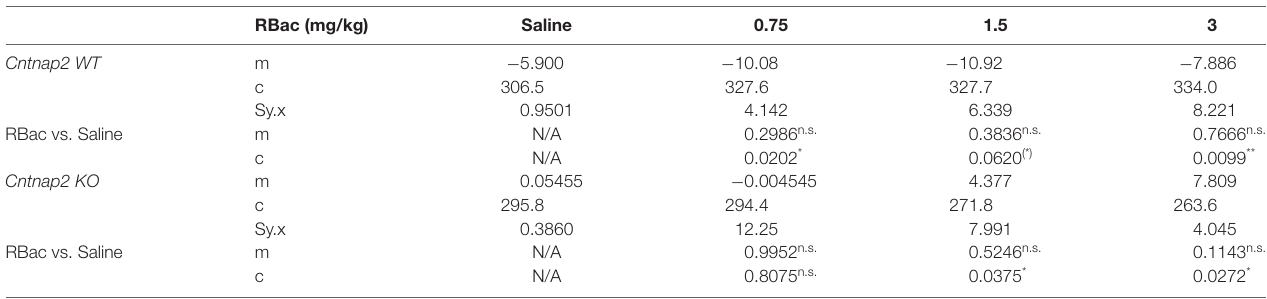
TABLE 4 | Linear regression of ASR peak latencies in Cntnap2 WT and KO rats after treatment with saline or R-Baclofen (0.75, 1.5, 3 mg/kg).